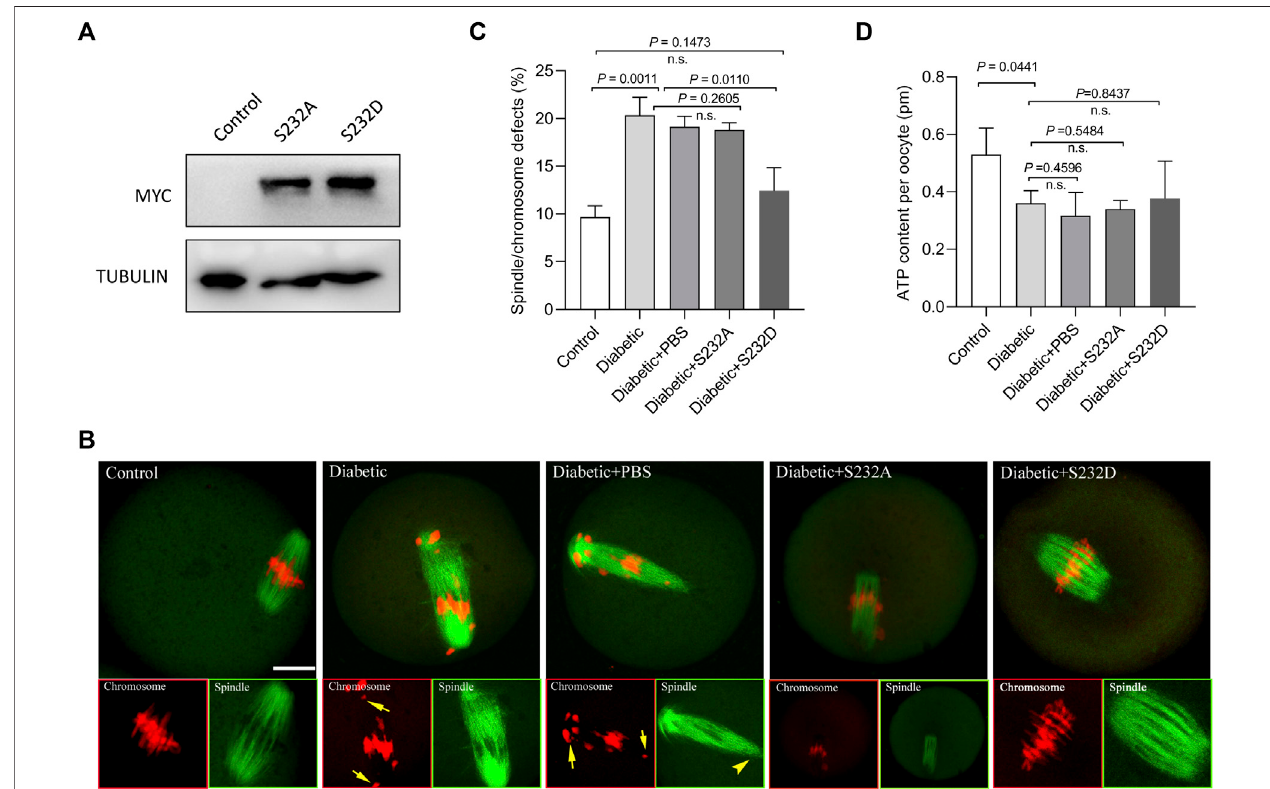
FIGURE 5 | Phospho-mimetic mutant of Ser232-PDHE1 α partially rescues de fi cient phenotypes of oocytes from diabetic mice. (A) Western blotting analysis showing that exogenous PDHE1 α mutants were ef fi ciently overexpressed, probing with anti-MYC antibody. (B) Control, diabetic, diabetic + PBS, diabetic + S232A- PDHE1 α , and diabetic + S232D-PDHE1 α oocytes were labeled with α -tubulin antibody to show the spindle (green) and stained with PI to show chromosomes (red). Arrowsdenotechromosomemisalignmentandarrowheadsdenotespindledefect,respectively.Scalebar:20 µm. (C) Quanti fi cationofcontrol,diabetic,diabetic+ PBS,diabetic+S232A-PDHE1 α ,and diabetic+S232D-PDHE1 α oocytes with spindle/chromosomedefects.Dataare expressed asmean percentage ± SD from three independent experiments in which at least 90 oocytes were analyzed. n.s., not signi fi cant. (D) Histogram showing the ATP level in control, diabetic, diabetic + PBS, diabetic + S232A-PDHE1 α , and diabetic + S232D-PDHE1 α ( n (cid:1) 50 for each group). n.s., not signi fi cant.